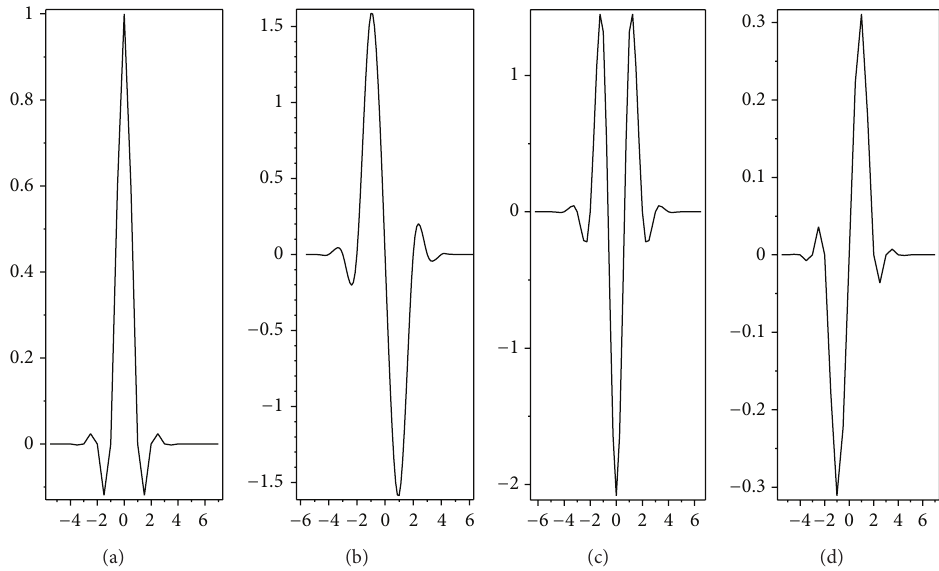
Figure 1: Interpolatory basis function 𝜙 3 (𝑖) is shown in (a), first derivative of 𝜙 3 (𝑖) i-e. 𝜙 󸀠 3 (𝑖) shown in (b), second derivative of 𝜙 3 (𝑖) i-e. 𝜙 󸀠󸀠 3 (𝑖) shown in (c), and third derivative of 𝜙 3 (𝑖) i-e. 𝜙 󸀠󸀠󸀠 3 (𝑖) shown in (d),